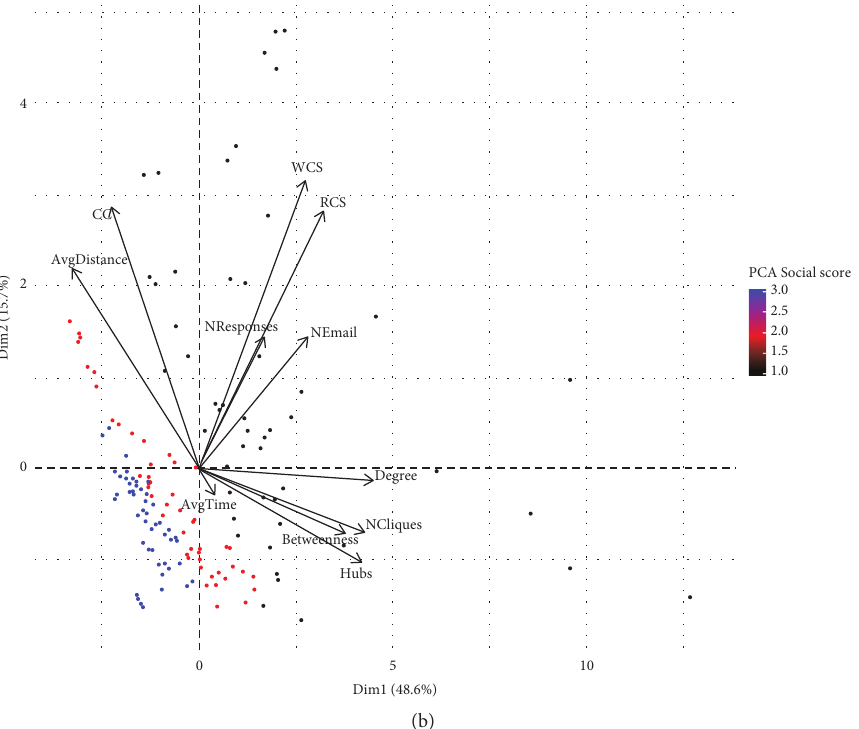
Figure 2: Clusters and features by two main principal components according to K -means (a) and the PCA CorpRank score (b) for Enron. The distance between each feature and the origin is proportional to the quality of its representation on the factor map. Feature definition is in Algorithm 1. (a) Clusters by K -means. (b) Clusters by PCA CorpRank score. Table 10: CorpRank scores of employees: Enron North American subsidiary. RCS: raw clique score, WCS: weighted clique score, Btw: betweenness, Avg. dist.: average distance, CC: clustering coefficient, score: CorpRank score. # Position e-mail